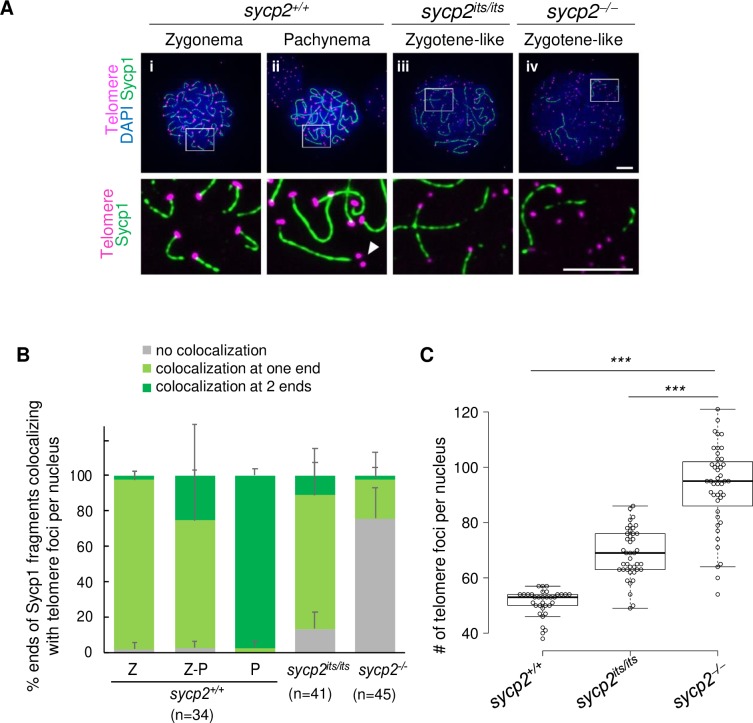
Ectopic localization of Sycp1 and paring defects at telomeres in sycp2 mutant spermatocytes.A: Costaining of telomeres and Sycp1 on sycp2+/+ (i-ii), sycp2its/its (iii), and sycp2-/- (iv) spermatocyte chromosomal spreads. The regions outlined with white are shown at a higher magnification at the bottom. The nuclei of sycp2+/+ spermatocytes are at zygonema (i; telomere detected at one end of each Sycp1 filament) and pachynema (ii; telomeres detected at both ends of Sycp1 filaments). Scale bars, 5 μm. B: Colocalization of Sycp1 fragments with telomere foci stained by the telomere-targeting polyamide at their ends in sycp2+/+, sycp2its/its and sycp2-/- spermatocytes. The percentages of Sycp1 filaments that did not colocalize or that colocalized at one or both ends with telomeres are shown in gray, light green and green, respectively. Each pool corresponds to the nuclei counted in S6 Fig. Error bars indicating the SD are shown only for the plus direction. A small fraction of Sycp1 ends did not colocalize with telomere foci, but two telomere foci were observed in close proximity (Fig 4A, arrowhead). These sites were possible locations at which synapsis or desynapsis was in progress. C: Numbers of telomere foci in sycp2+/+, sycp2its/its and sycp2-/- spermatocytes. Telomere foci stained by the telomere-targeting polyamide were counted in nuclei with Sycp1 filaments of each genotype. Center lines show the medians; box limits indicate the 25th and 75th percentiles as determined by R software; whiskers extend 1.5 times the interquartile range from the 25th and 75th percentiles; data points are plotted as open circles. Chromosomal spreads of one (wild-type) or two (sycp2its/its and sycp2-/-) individual fish were used for counting. sycp2+/+, n = 34; sycp2its/its, n = 41; and sycp2-/-, n = 45. *** indicates p<0.0001 (Student’s t-test).